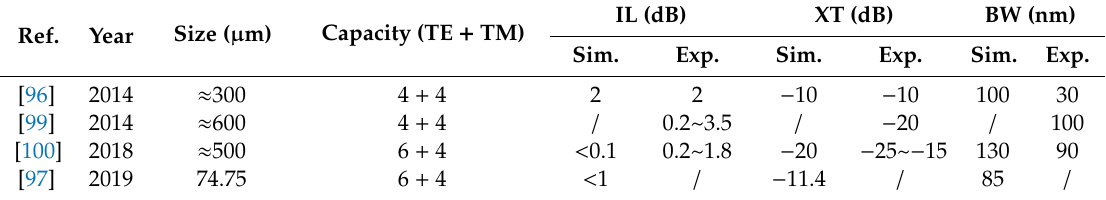
Table 3. Summary of the reported silicon polarization / mode hybrid (de)multiplexers.